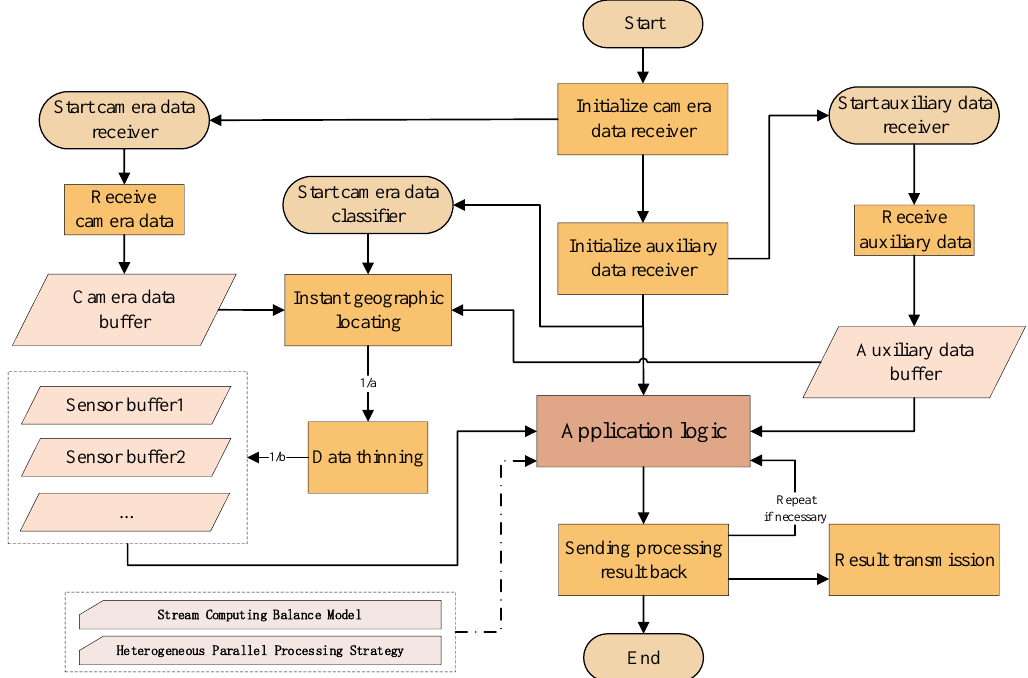
Figure 5. Flowchart of a typical application using a standard template.